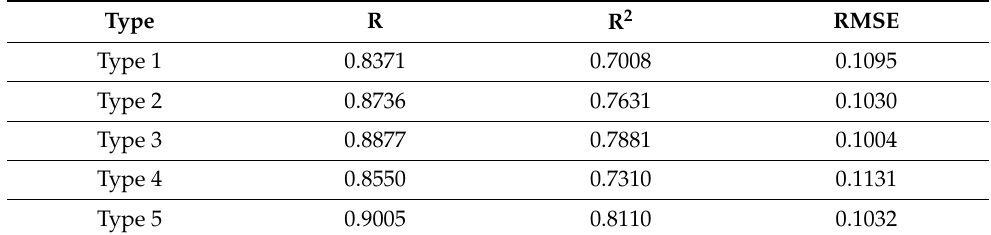
Table 4. Regression analysis results of two-dimensional equations for predicting the peak compressive strength of the SMA-confined concrete cylindrical specimens.